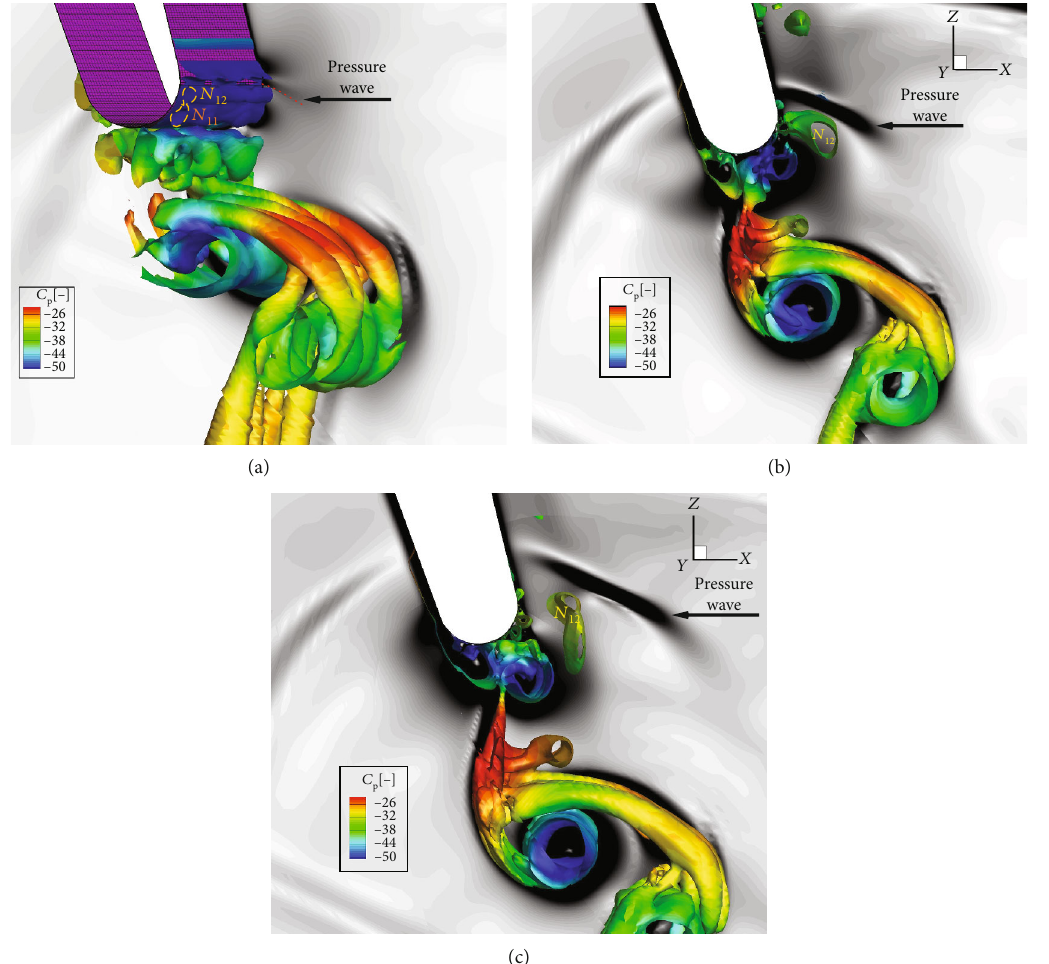
Figure 11: The formation and development of suction-side pressure wave (density gradient contours and Q-criterion isosurfaces colored by C t = 0 : 68 T t = 0 : 87 T t = 1 : 04 T p ): (a) 3 wake ; (b) 4 wake ; (c) 5 wake